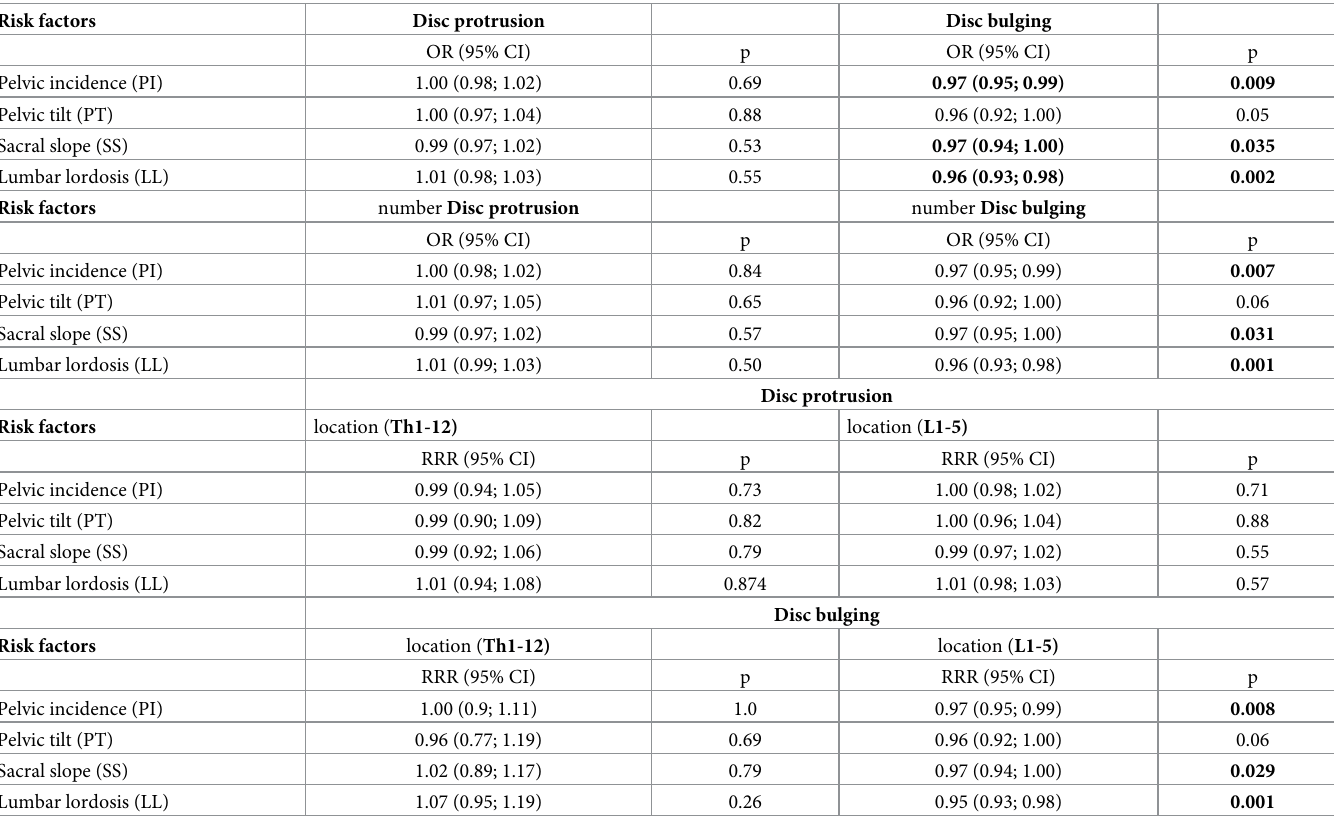
Table 5. a. Multivariable correlation of spinopelvic parameters with disc protrusion and disc bulging independent of the number of disc herniation per patient. b. Multivariable correlation of spinopelvic parameters with disc protrusion and disc bulging depending on the number of disc herniation per patient. c. Multivariable correla- tion of spinopelvic parameters with disc protrusion depending on the location (thoracic: Left; lumbar: Right). d. Multivariable correlation of spinopelvic parameters with disc bulging depending on the location (thoracic: Left; lumbar: